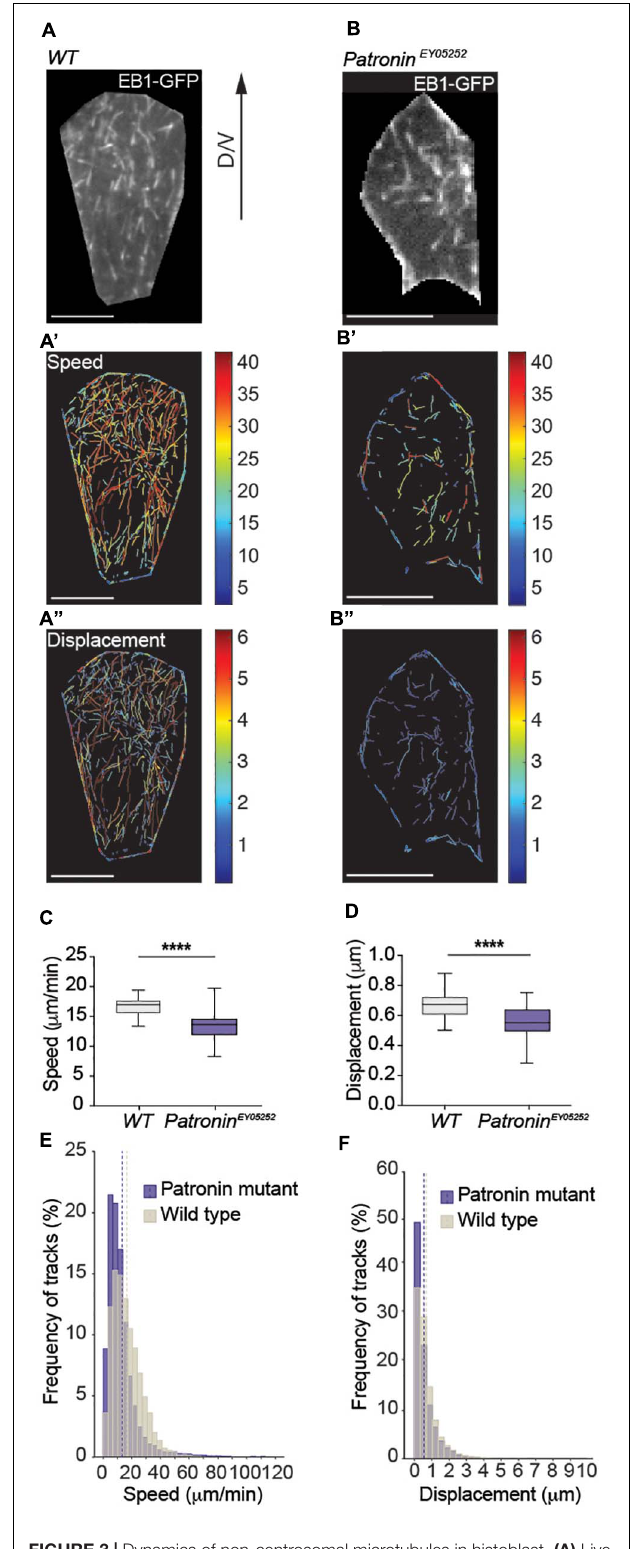
FIGURE 3 | Dynamics of non-centrosomal microtubules in histoblast. (A) Live fluorescence images of EB1-GFP in wild-type histoblasts and corresponding